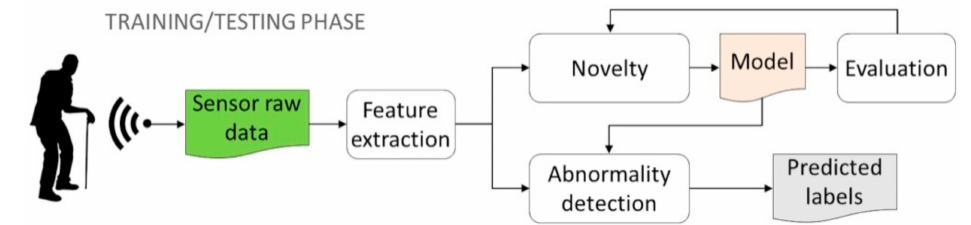
Figure 13. Workflow of unsupervised detection